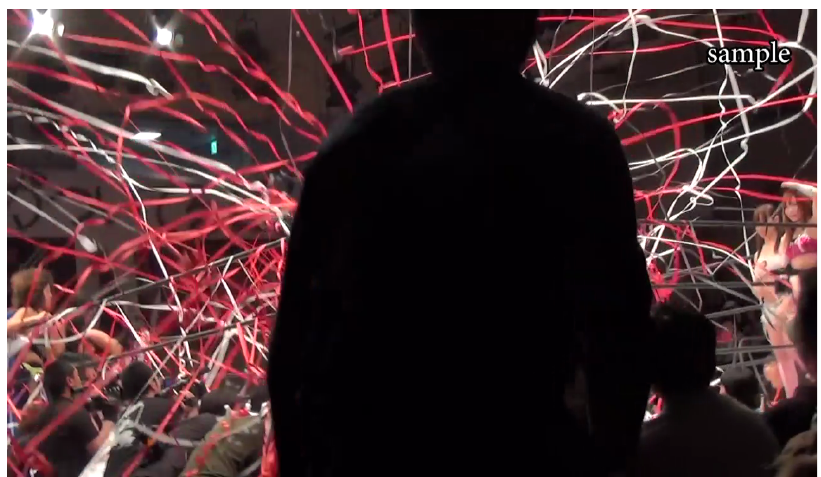
Fig. 6. Yasukawa falls under the fans’ shadow. After Gamushara